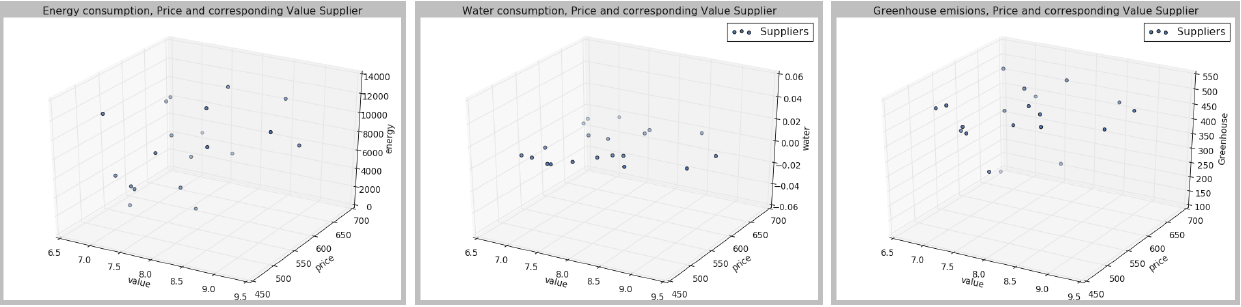
Figure 3. Case 1, according to the preferences described in Table